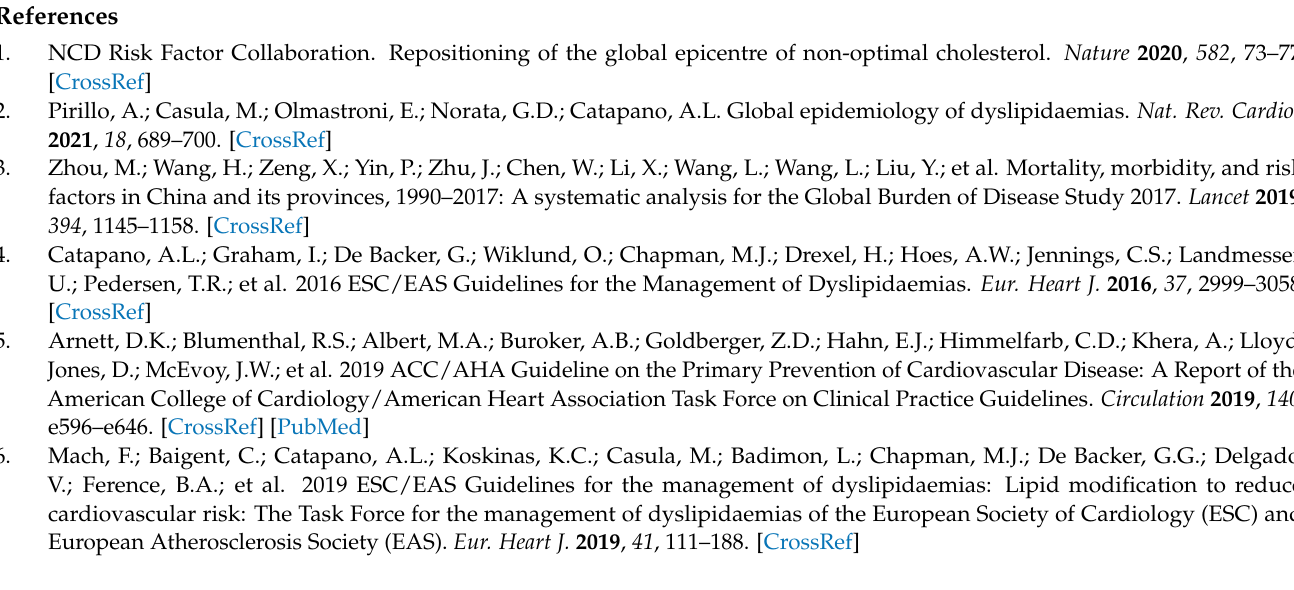
and methods for calculating intake, Table S1: Definitions of selected food groups [38], Table S2: Characteristics of participants according to quintiles of energy-adjusted total fat and fats of various types and sources, Table S3: Comparison of the proportion of various fats in total fat intake, stratified by the median of total fat ( n = 39,115), Table S4: Regression coefficient (95% CI) and standardized coefficients for the association between dietary fats (per 11 g) and lipid markers, Table S5: Blood lipid levels (TC, LDL-c, HDL-c, TCHDL, TG, TGHDL) by quintiles of various dietary fats intake ( n = 39,115), Table S6: Beta coefficient (95% CI) for change in lipid biomarkers for per 11 g increment of animal/plant saturated fats, animal monounsaturated fats, and polyunsaturated fats, stratified by intake levels, Figure S1: Quantity and food sources of dietary fats in various types in survey population, Figure S2: Quantity and food sources of dietary fats in various types in selected sample ( n =